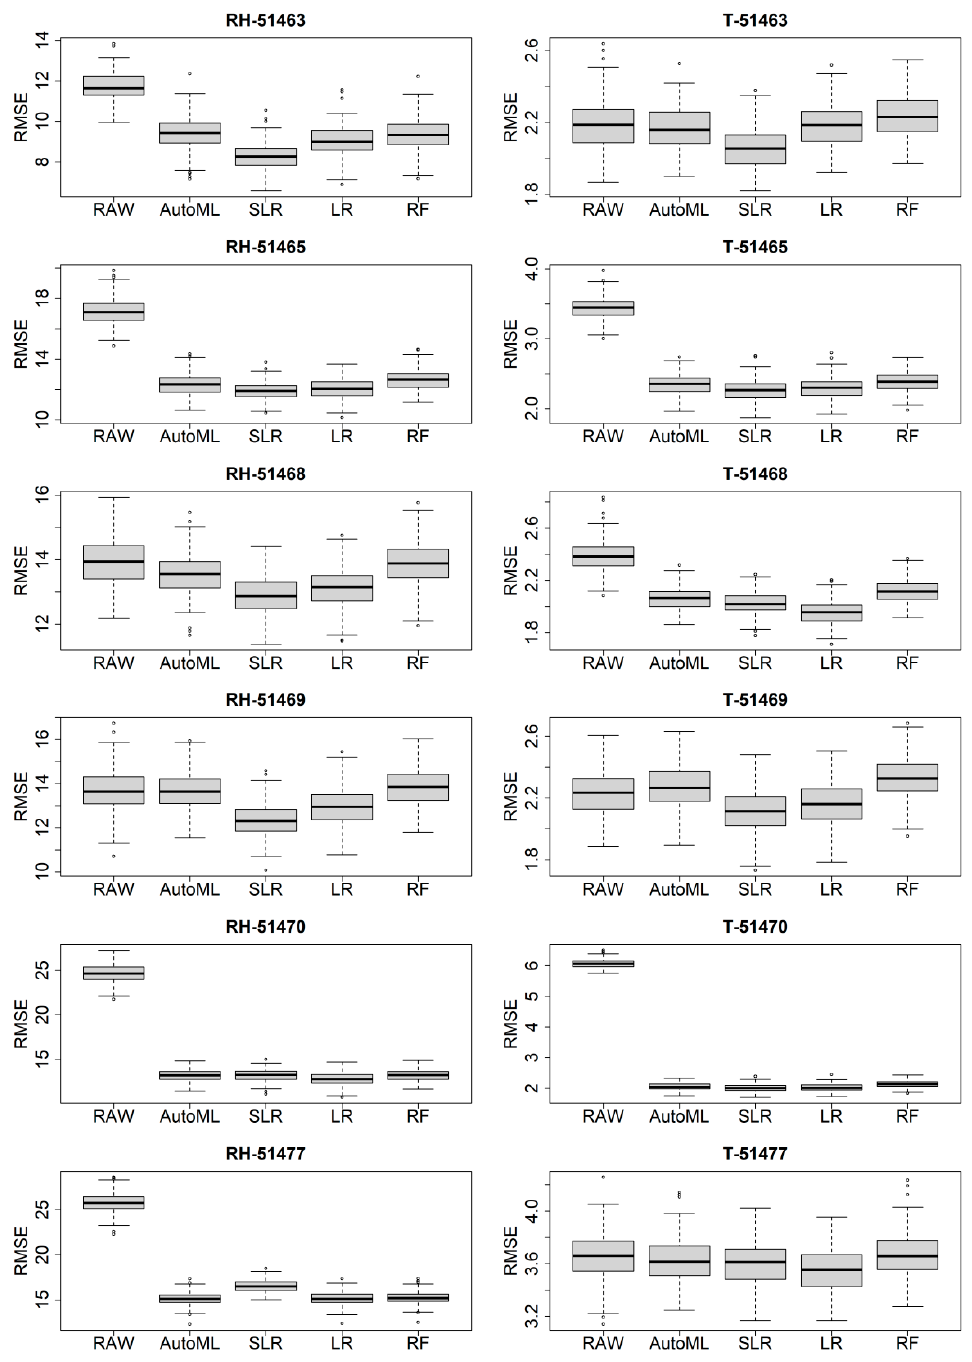
Figure 12. The boxplot of RMSE values by raw forecast, AutoML, SLR, LR, and RF models evaluated with bootstrap sampling method.